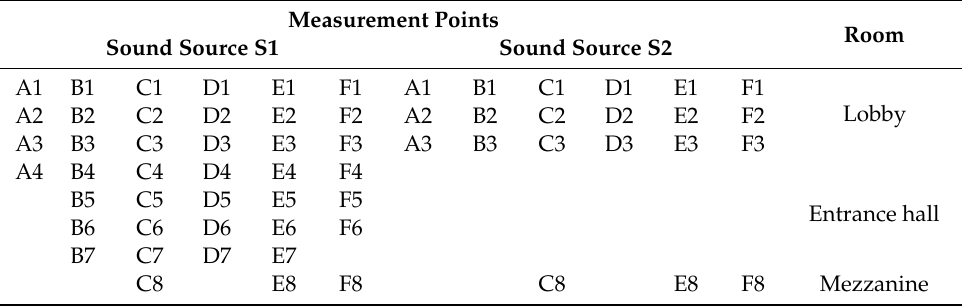
Table 4. Measurement points of rapid speech transmission index,